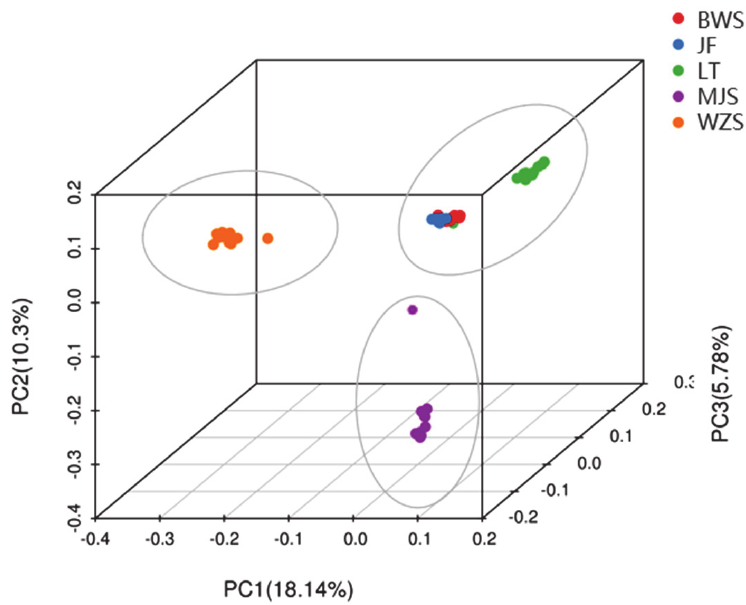
Figure 4. PCA plot of the 52 P. bungeana individuals based on the population SNPs.